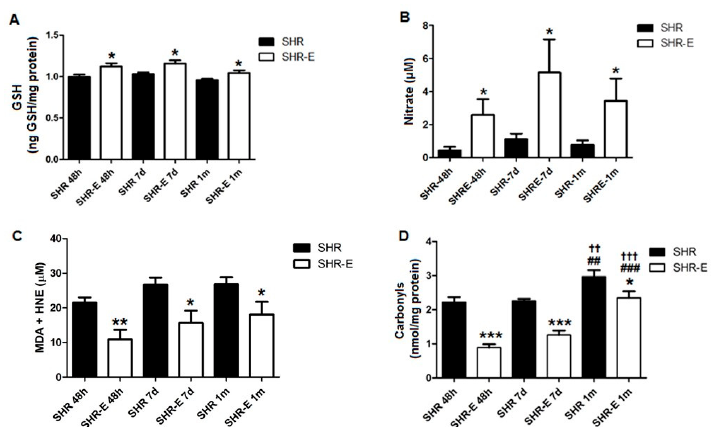
Figure 5. Oxidative status biomarkers. Reduced glutathione (GSH) ( A ), nitrate ( B ), malondialdehyde + 4-hydroxynonenal (MDA + HNE) ( C ) and carbonyls ( D ) in plasma of treatment groups (48 h) and withdrawal groups (7 days and 1 month). SHRs, rats treated with vehicle; SHR-Es, rats treated with esmolol; n = 8 rats for each experimental group. Values are mean ± SEM. * p < 0.05, ** p < 0.01, *** p < 0.001 vs. SHRs; ## p < 0.01, ### p < 0.001 SHR 1 m/SHR-E 1 m groups vs. SHR 48 h/SHR-E 48 h groups; †† p < 0.01, ††† p < 0.001 SHR 1 m/SHR-E 1 m groups vs. SHR 7 d/SHR-E 7 d groups.